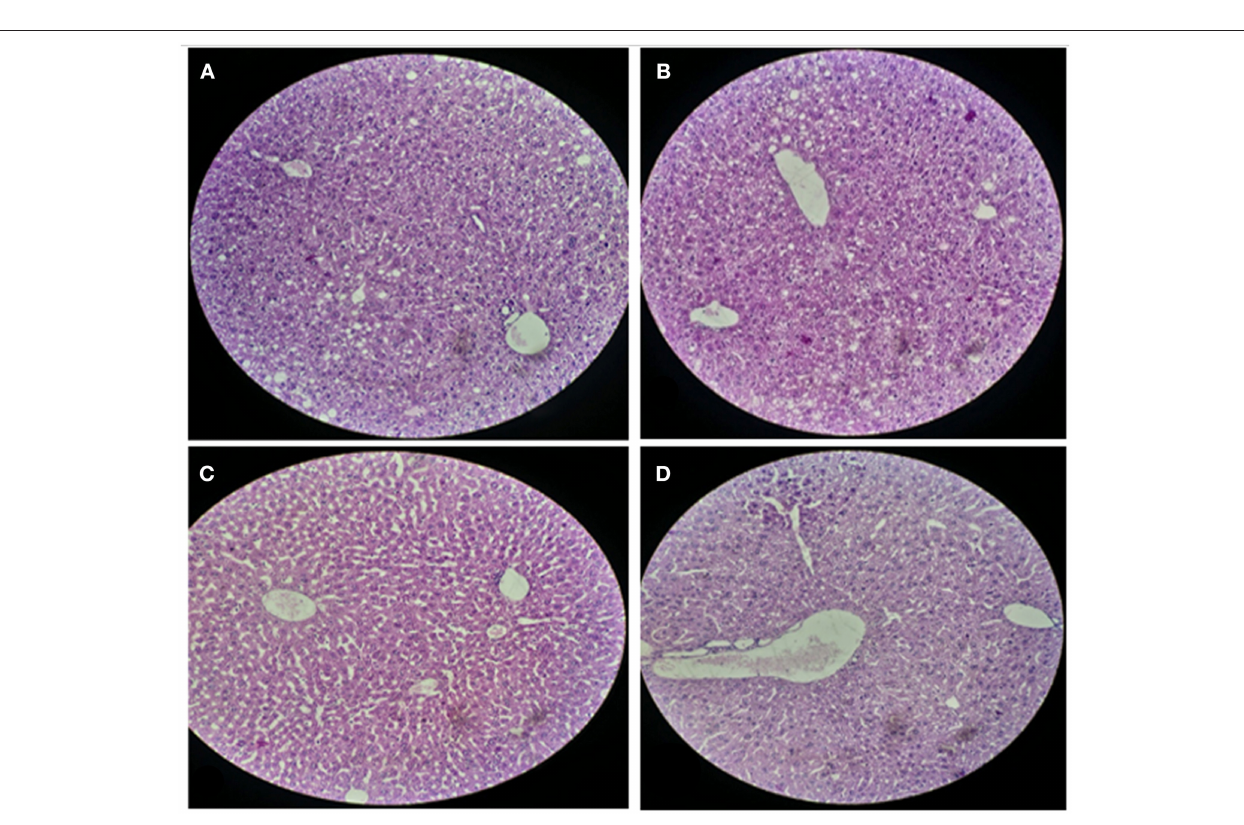
one incomplete prophage of 7.036 kb with 35.42% GC